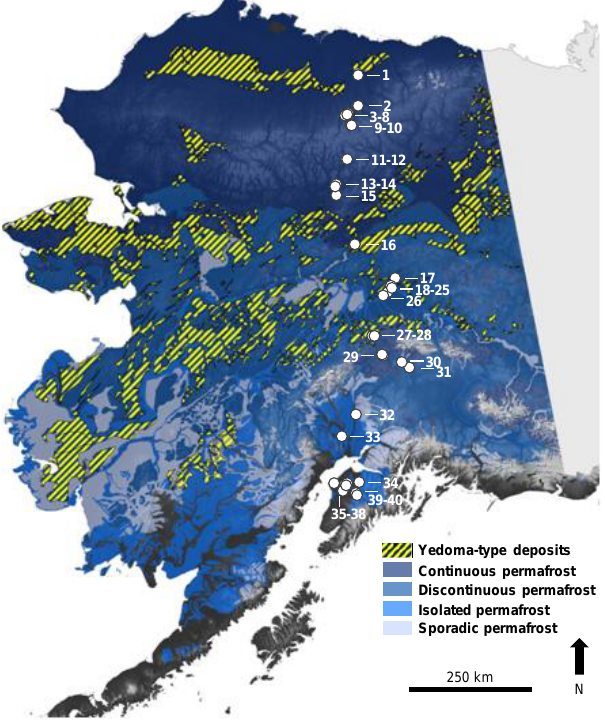
Figure 1. Locations of study lakes in Alaska (circles) plotted on the Alaska DEM hillshade raster. Information about the distribution of yedoma-type deposits (ice-rich silt containing deep thermokarst lakes) and permafrost is from Jorgenson et al. (2008) and Kanevskiy et al. (2011). The Alaska map is the National Elevation Dataset 30m hillshade